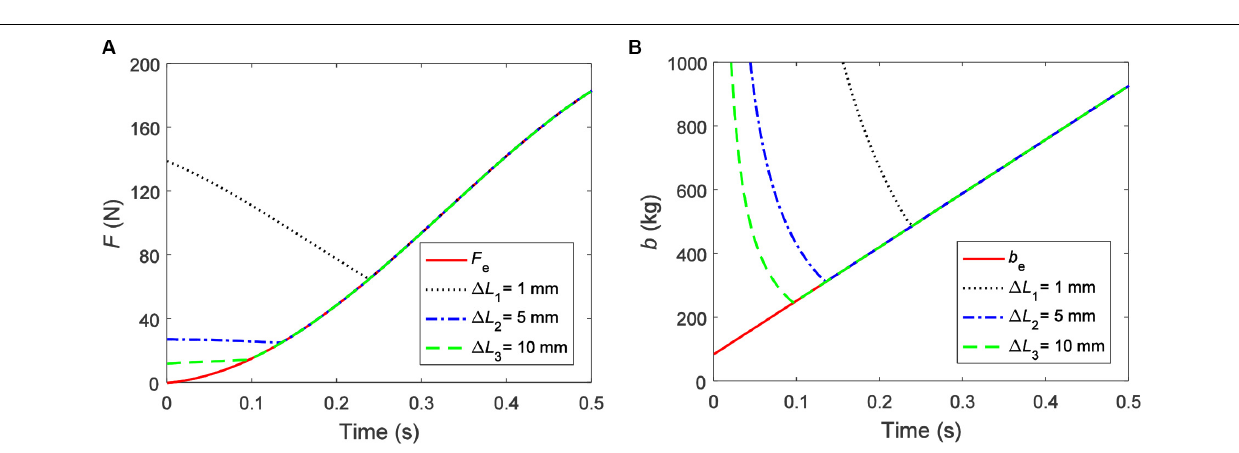
the uncontrollable torque T η is gradually reduced from about 0.22 to 0 Nm. The controllable torque T τ is 0 Nm before the inertance of 486 kg, after which it gradually fits with the